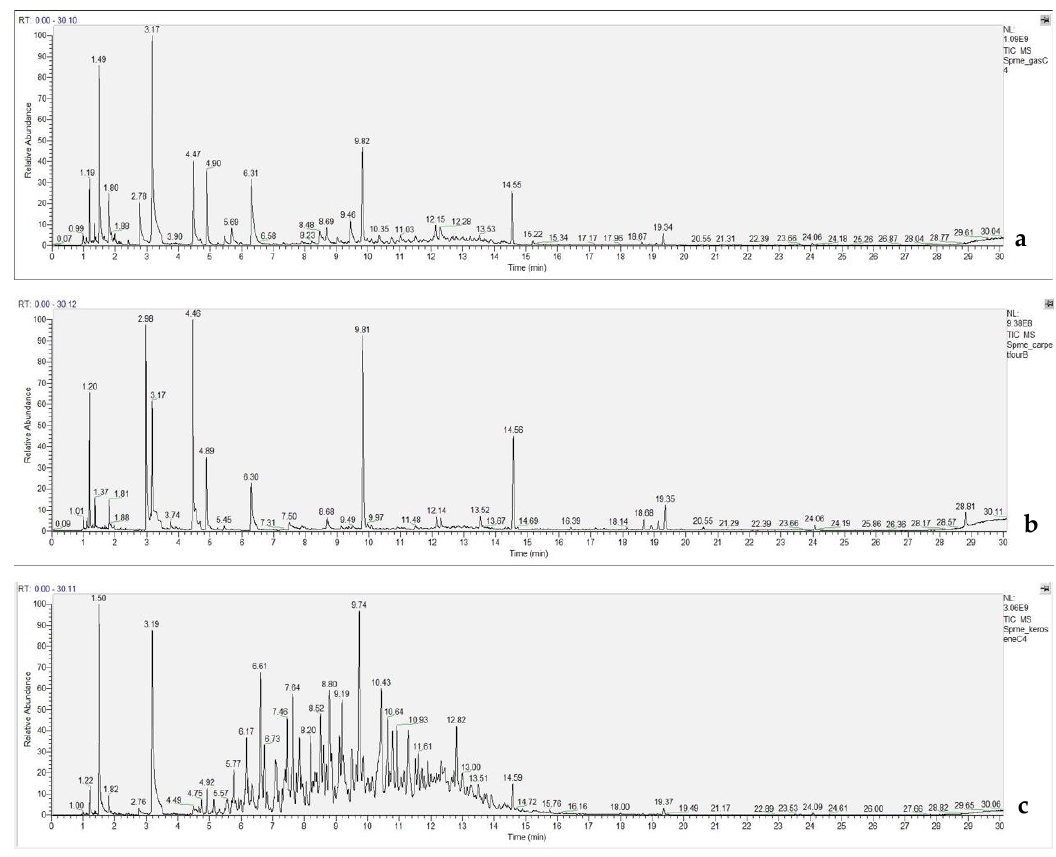
Figure 10. Total ion chromatograms ( m / z 50–500) of carpet #3 ( a ) burned without ILs; ( b ) burned with gasoline; ( c ) burned with kerosene.